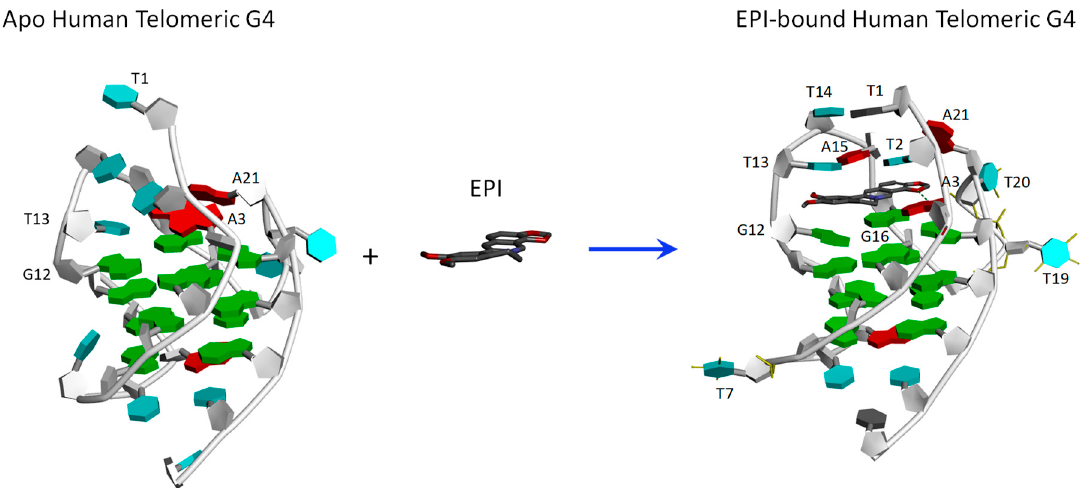
Figure 2. Binding of EPI induces a complete rearrangement of the 5’-end structure of the human telomeric G4 [6].